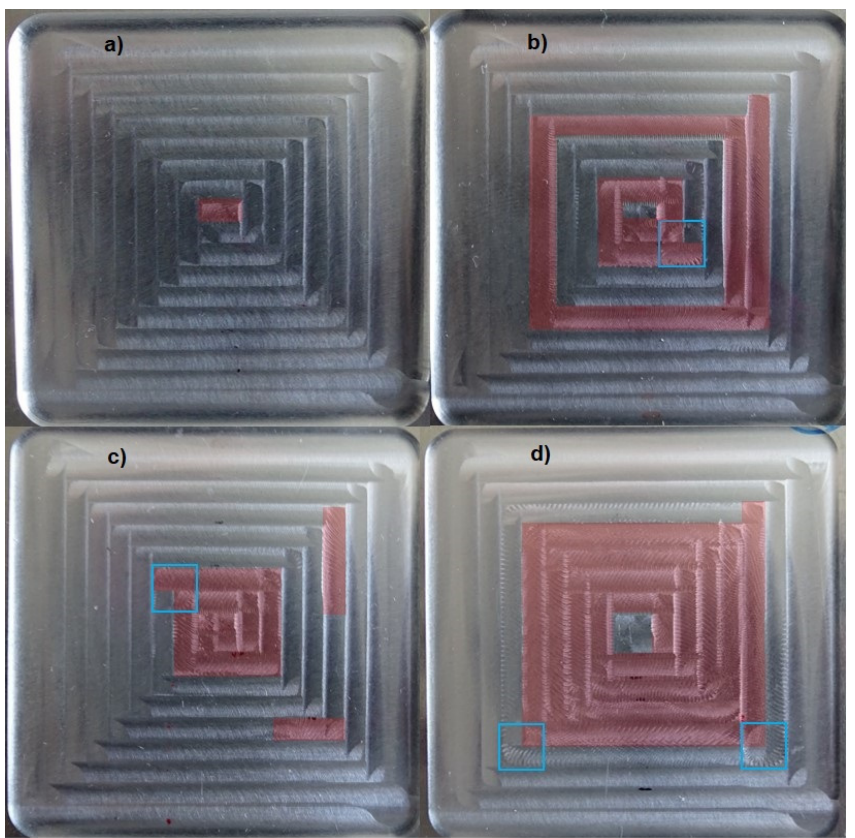
Figure 9. Samples after milling. Chatter marks in red, ploughing marks in blue square. ( a ) TP10. ( b ) TP08. ( c ) TP04. ( d ) TP02.